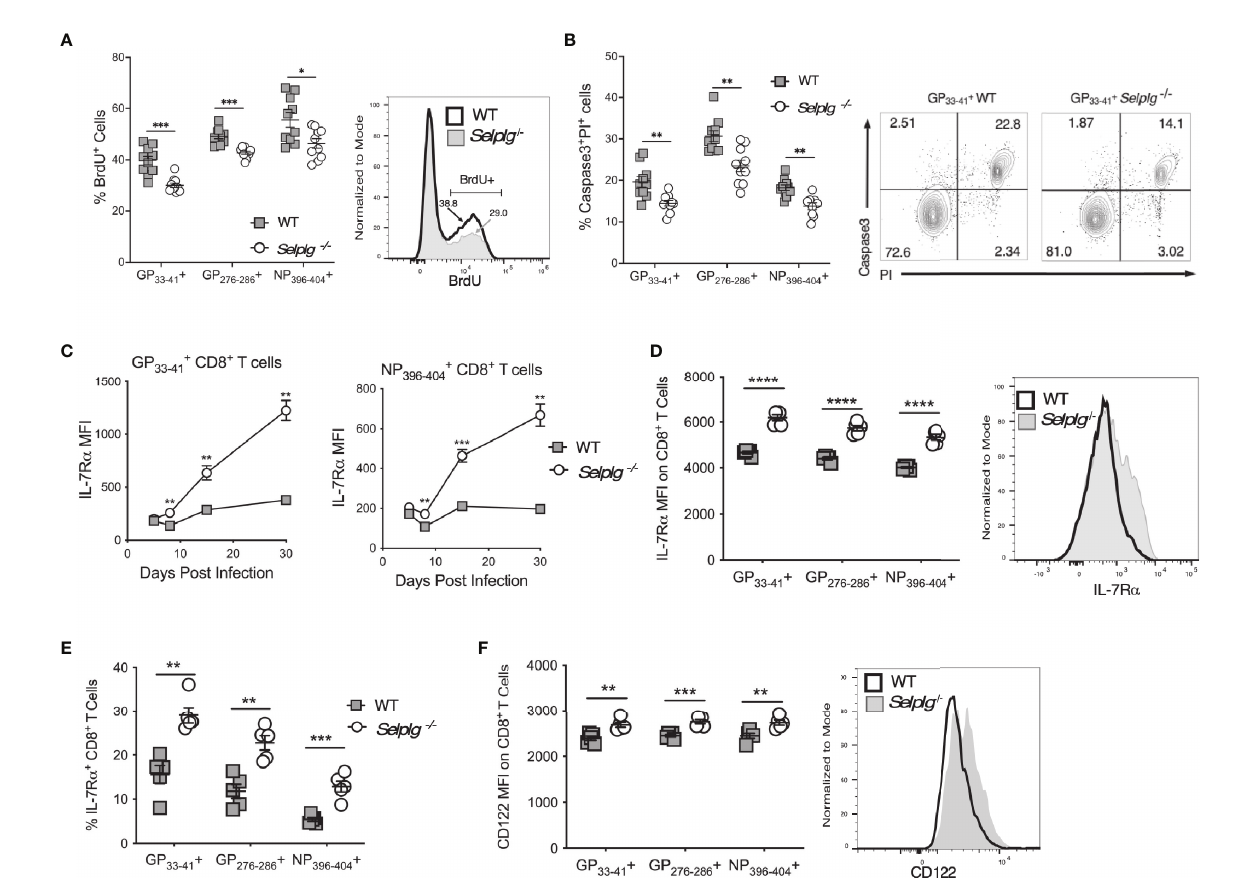
FIGURE 2 | Selplg -/- effector and memory T cells have increased survival. WT and Selplg -/- mice were infected with LCMV Armstrong by i.p. injection. (A) CD8 + T cells were analyzed for the frequencies of BrdU incorporating CD8 + tetramer + T cells, with a representative histogram for GP 33 − 41 + cells. (B) Frequencies of Caspase 3 + PI + CD8 + tetramer + T cells at 8dpi, with a representative dot plot showing the frequencies for GP 33 − 41 + T cells. (C) Geometric mean fl uorescence intensity (MFI) of IL-7R a levels expressed on CD8 + tetramer + cells from the blood at the indicated time points and (D) at 30dpi from the spleen, with a representative histogram for GP 33 − 41 + cells. (E) The frequencies of IL-7R a + , tetramer + CD8 + T cells. (F) The levels CD122 expressed on tetramer + cells in spleen at 30dpi expressed as MFI, with a representative histogram for GP 33 − 41 + cells. Data are representative of three independent experiments (n = 5 or more mice/group). Graphs show the mean ± SEM. * p < 0.05, ** p < 0.005, *** p < 0.001, **** p < 0.0001 by two-tailed unpaired t- test (A – F)